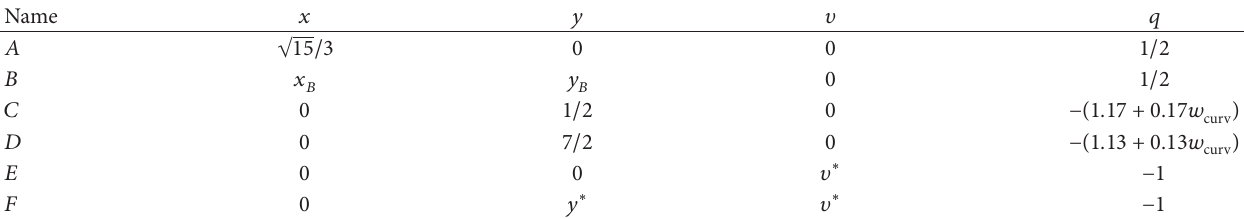
= −1 . . The critical curve 𝐹 exists just for 𝑤 curv curv